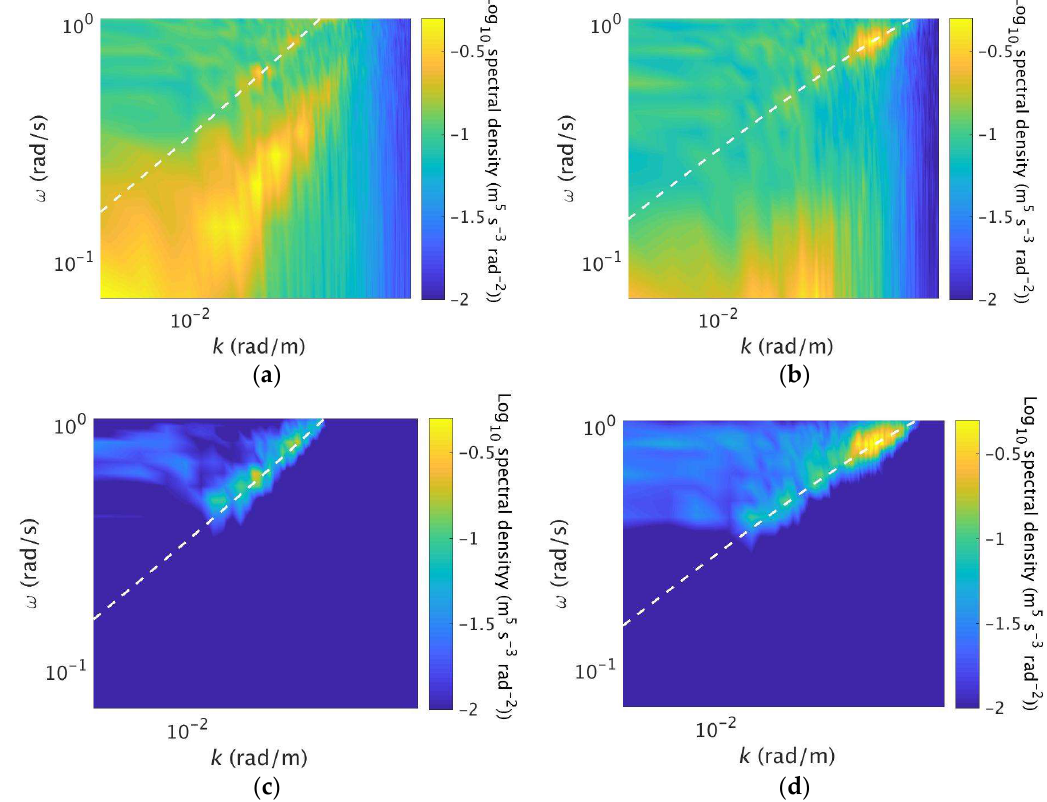
Figure 7. (a) an example k - ω POD reconstruction spectrum for dataset 1 using 32 modes ( n = 32). (b) k - ω POD reconstruction spectrum for dataset 2 using 6 modes ( n = 6). (c) k - ω spectrum for the dispersion curve filtered result for dataset 1 and (d) k - ω spectrum for the dispersion curve filtered result for dataset 2. Energy that appears above and to the left of the dispersion curve in (c) and (d) is an artifact of the 3D dispersion cone filtering integrated into 2D for presentation of the figure.